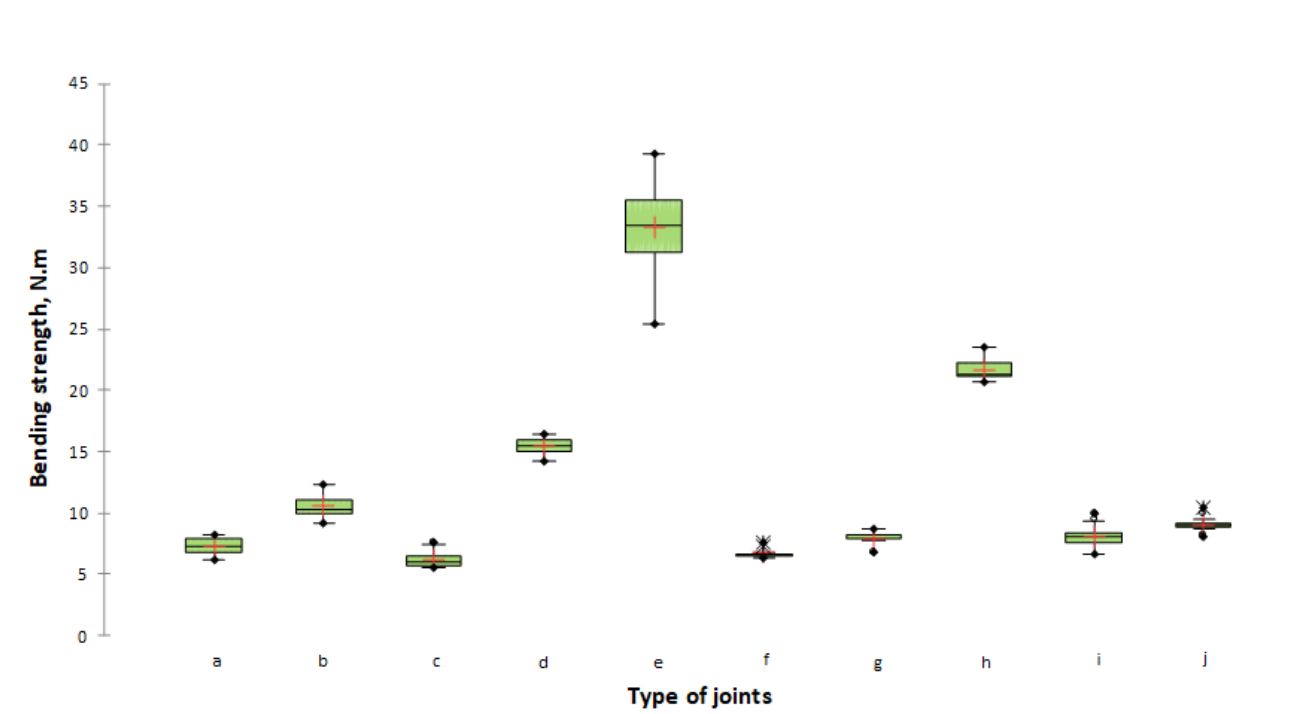
Figure 8. Bending strength under the compression test of L-type corner joints made of lightweight panels. The letter index of the type of joints is according to Figure 4. Table 3. Tukey HSD analysis of the differences between the groups with a confidence interval of 95% of bending capacity of joints of two materials of all pairwise